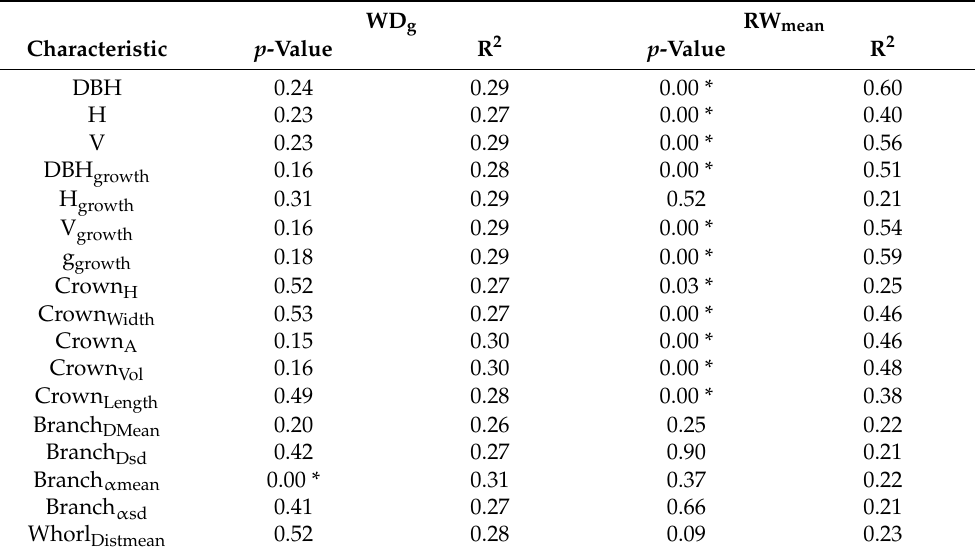
Table 6. The p-values and coefficient of determination (R 2 ) of the fitted linear mixed effects models (Equation (2)) and analysis of variance where ring basal area weighted mean wood density (WD g ) and mean ring width (RW mean ) were used as response variables and each tree structural characteristics (refer to Table 2 for descriptions) as predictor variables. * Indicates a statistical significance (i.e., p -value ≤